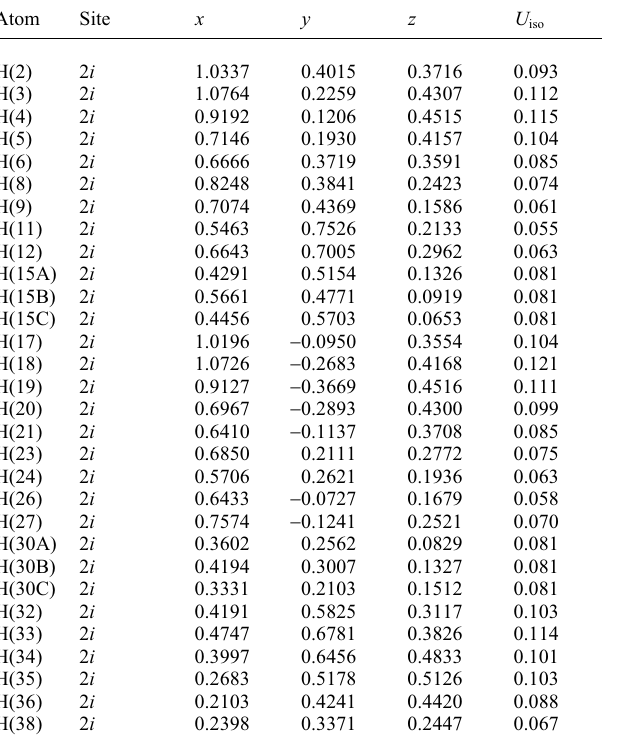
Table 3. Atomic coordinates and displacement parameters (in Å 2 )